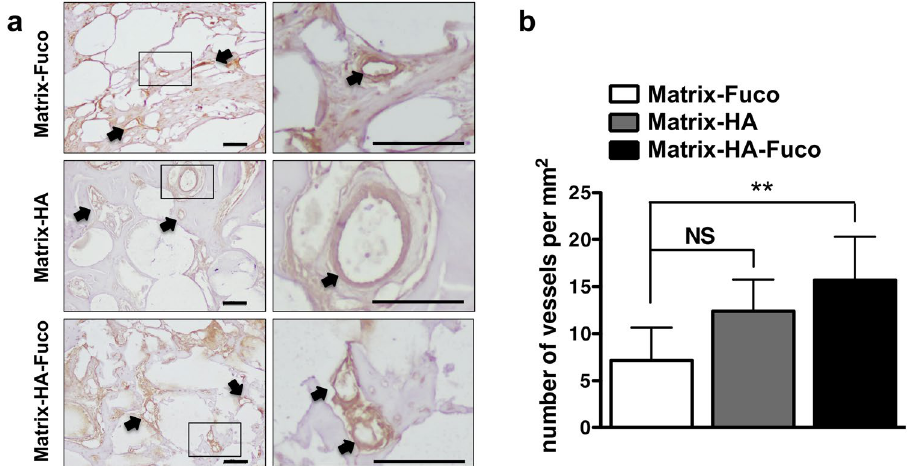
Figure 7. Immunohistochemistry evaluation of CD31 expression. ( a ) Representative images of CD31 staining of vessels in the three groups of implanted matrices (scale bar = 100 µ m). ( b ) Quantification of vessel density inside the implanted matrices at 5 weeks post implantation (n = 6; Average ± SD). NS and ** denote Non Significant and p < 0.01,